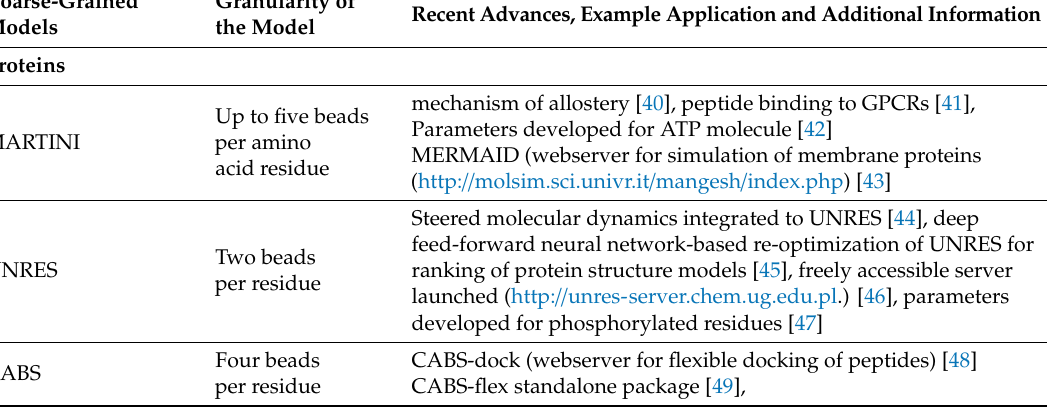
Table 1. Overview of recent progress in coarse-grained models and their